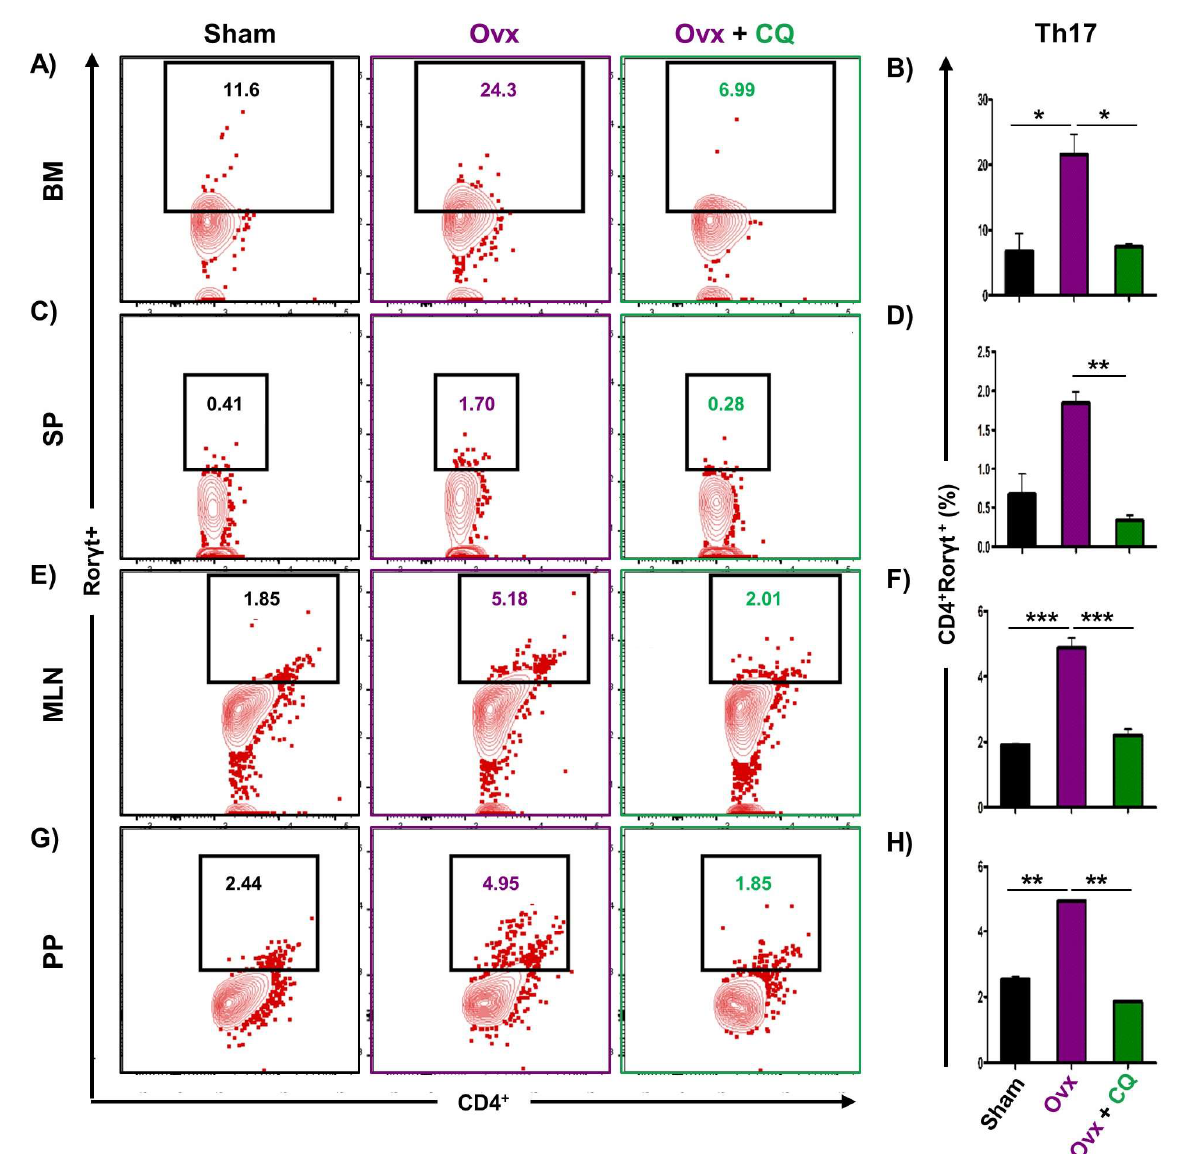
Figure 9. CQ administration decreases the Th17 cell population in Ovx mice : Cells harvested from the lymphoid organs of all the groups were analyzed by flow cytometry for the percentage of CD4 + Rorγt + Th17 immune cells. ( A ) Contour plot representing the percentage of CD4 + Rorγt + Th17 in BM. ( B ) Bar graphs representing the percentage of CD4 + Rorγt + Th17 in BM. ( C ) Contour plot re- presenting the percentage of CD4 + Rorγt + Th17 in SP. ( D ) Bar graphs representing the percentage of CD4 + Rorγt + Th17 in SP. ( E ) Contour plot representing the percentage of CD4 + Rorγt + Th17 in MLN. ( F ) Bar graphs representing the percentage of CD4 + Rorγt + Th17 in MLN. ( G ) Contour plot repre- senting the percentage of CD4 + Rorγt + Th17 in PP. ( H ) Bar graphs representing the percentage of CD4 + Rorγt + Th17 in PP. ANOVA was used to analyse the results, and then unpaired Student t-tests were used to compare the indicated groups. Values are expressed as mean ± SEM, and equivalent outcomes were observed in two independent experiments. For the indicated groups, p 0.05 (* p ≤ 0.05, ** p ≤ 0.01, *** p ≤ 0.001) was used as the cutoff for statistical significance.